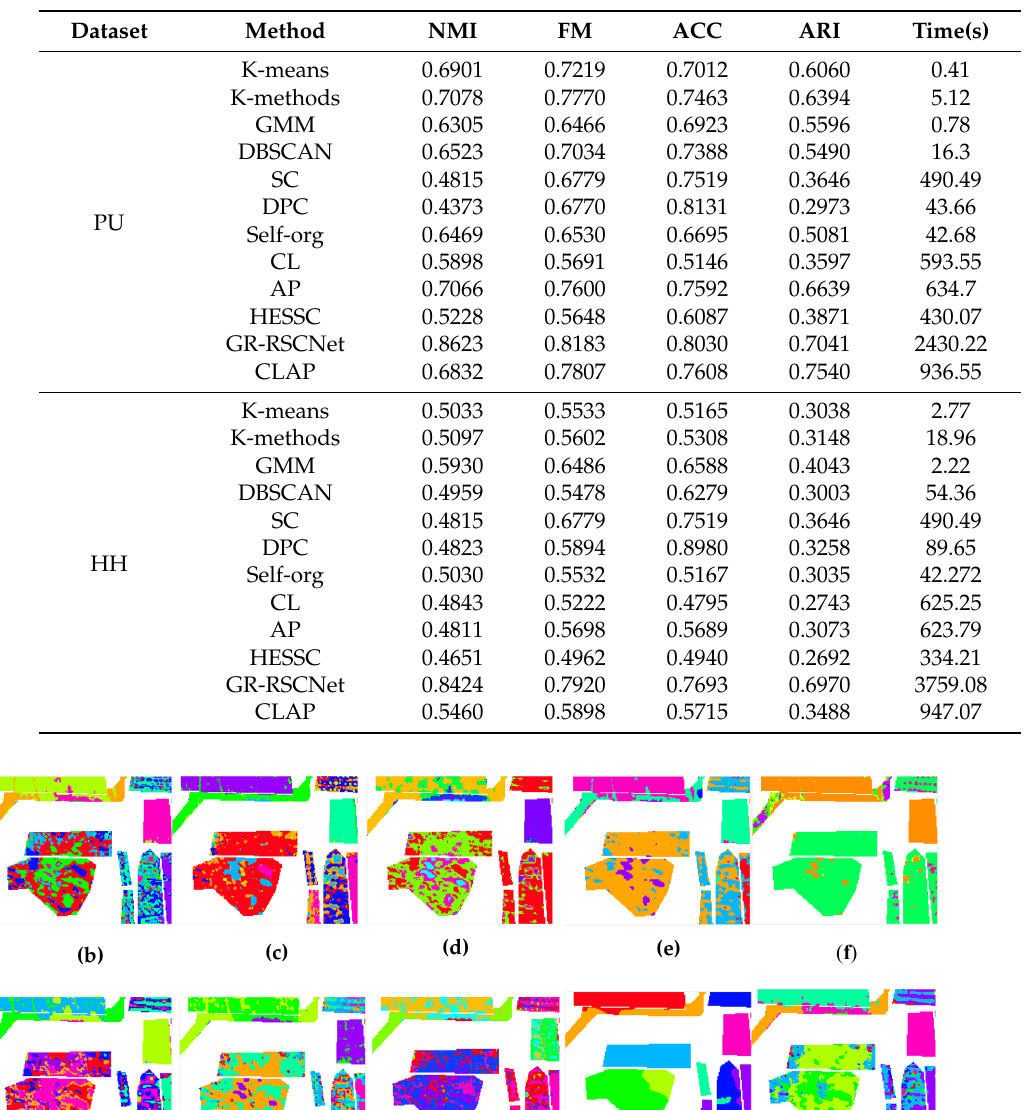
Table 4. Comparison results of the NMI, F ‐ measure, ACC, ARI, and running time of the algorithms in three HSI datasets.